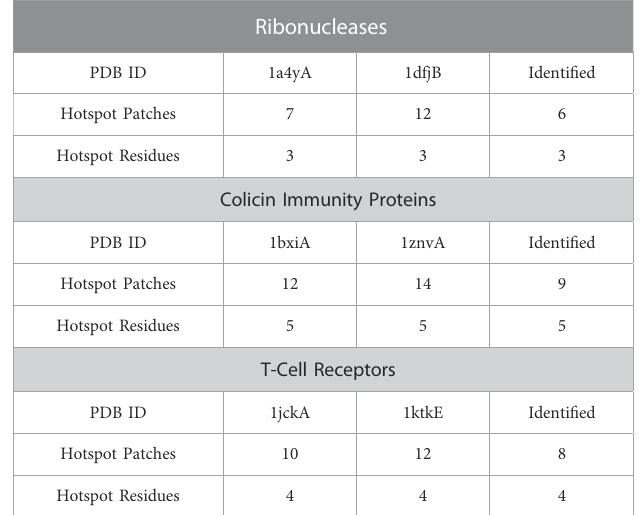
TABLE 1 Detection of hotspots using PPI-Surfer. Three pairs of PPI surfaces were compared with PPI-Surfer and corresponding patches were identi fi ed between them. Among the identi fi ed patch pairs, hotspot patches and residues were reported. Under each PDB ID, we listed the number of hotspot patches and hotspot residues of the entry. The numbers of detected hotspot patches and residues by PPI-Surfer are shown in the column of Identi fi